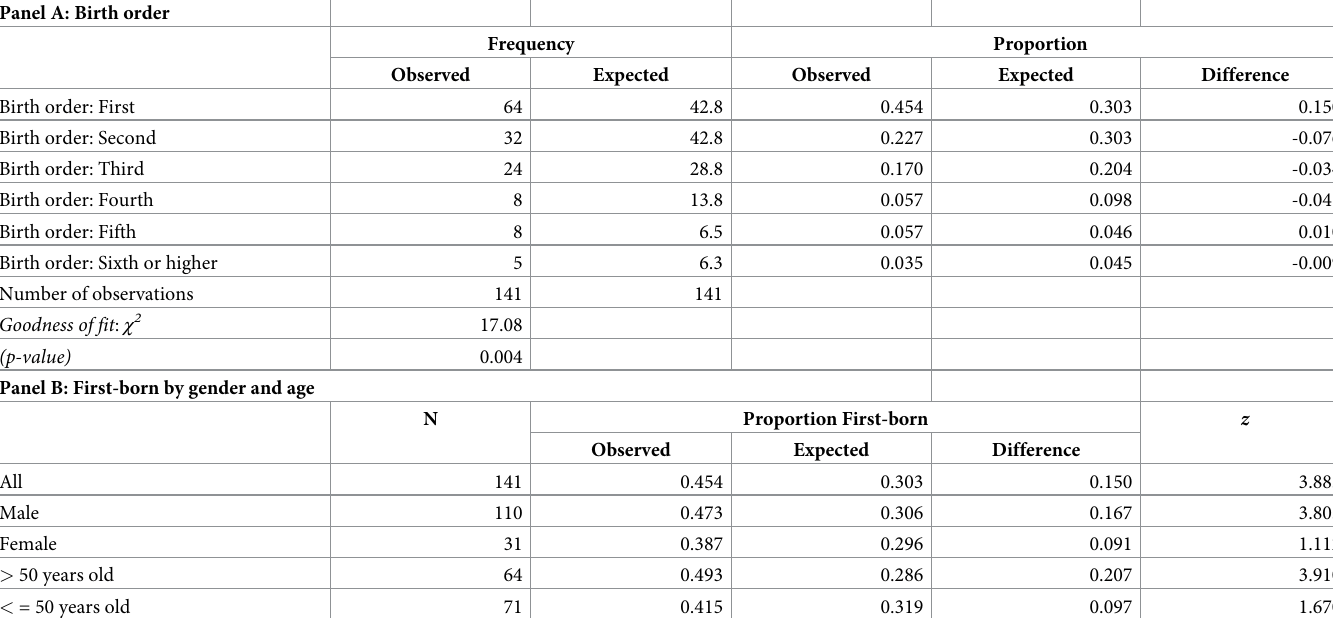
Table 2. Baseline